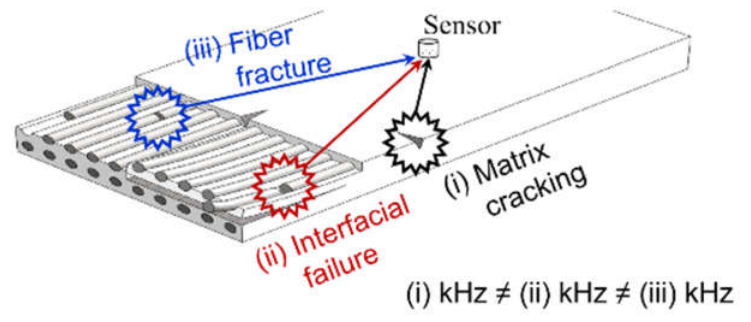
Figure 1. Schematic diagram.